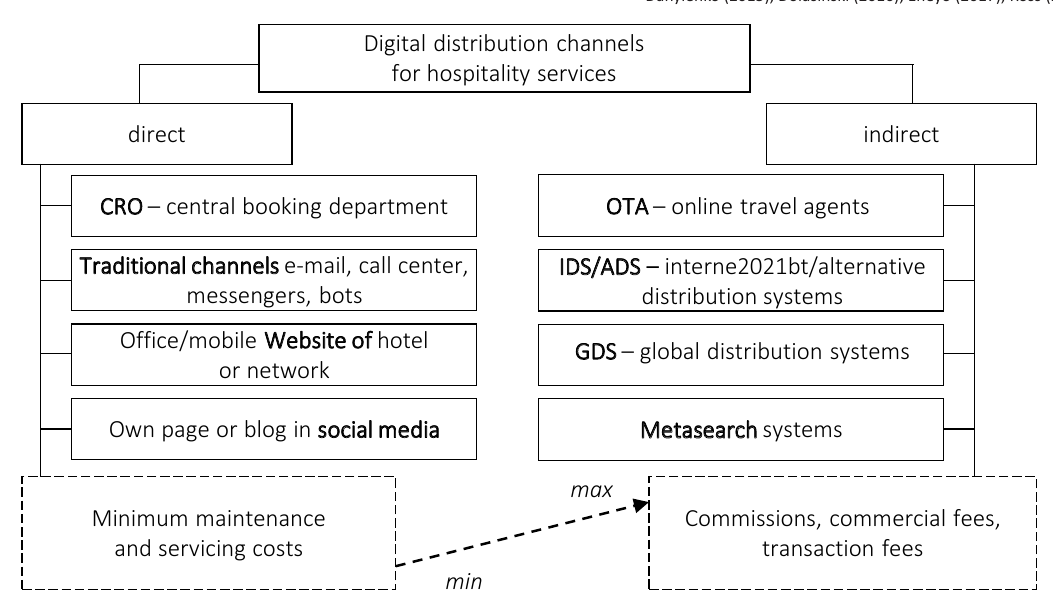
Figure 2. Types of online distribution channels for hospitality